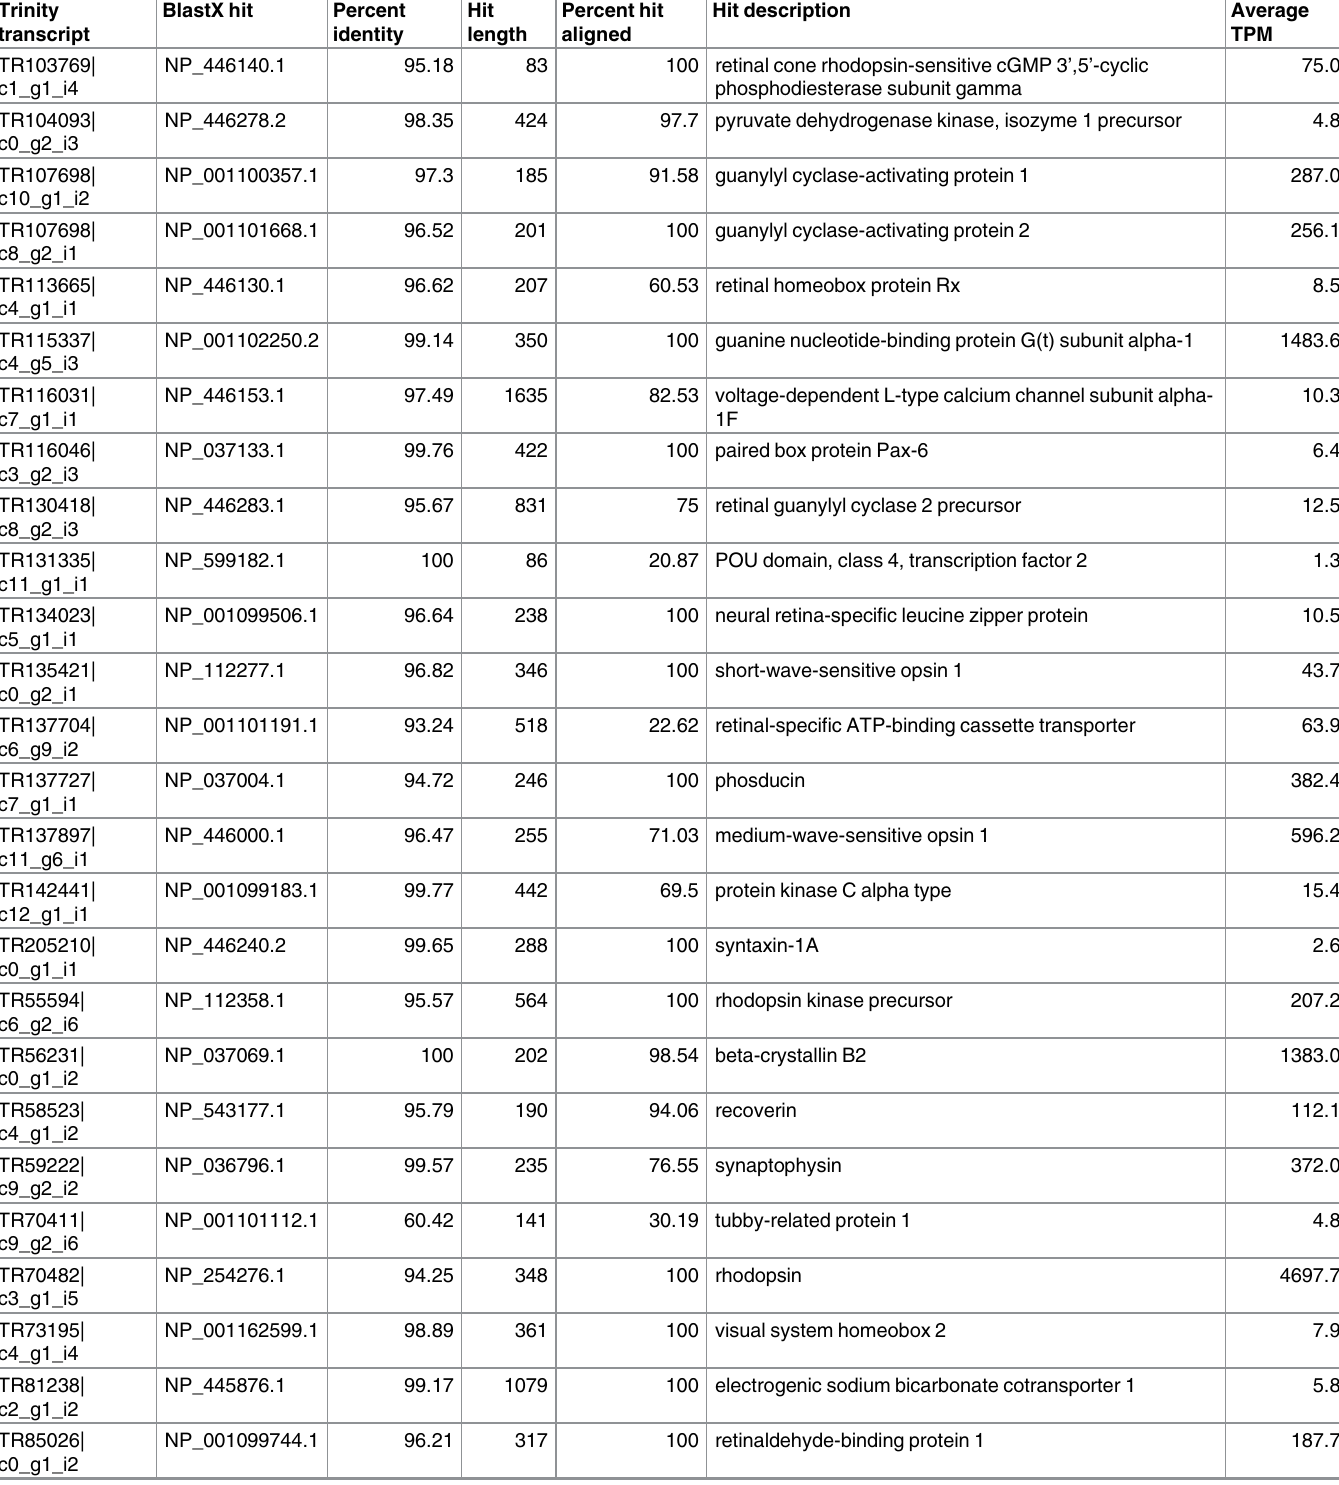
Table 3. Trinity transcripts with homology for selected retinal